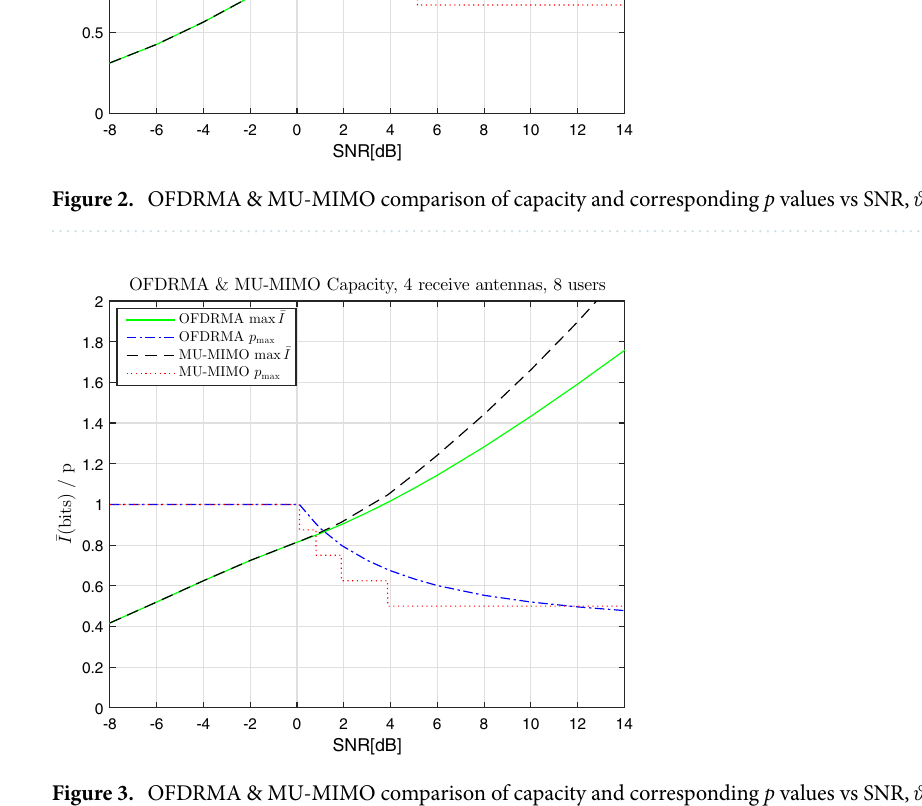
Figure 3. OFDRMA & MU-MIMO comparison of capacity and corresponding p values vs SNR, ϑ = 4 , u = 8